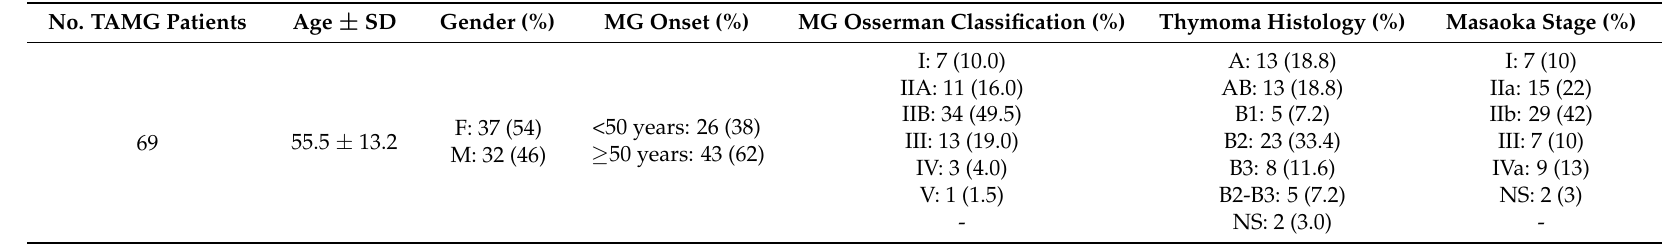
Table 2. Demographic and clinico-pathological characteristics of the studied population (TAMG: thymoma-associated myasthenia gravis, MG: myasthenia gravis, F: females, M: males, NS: no specified tumor histology).